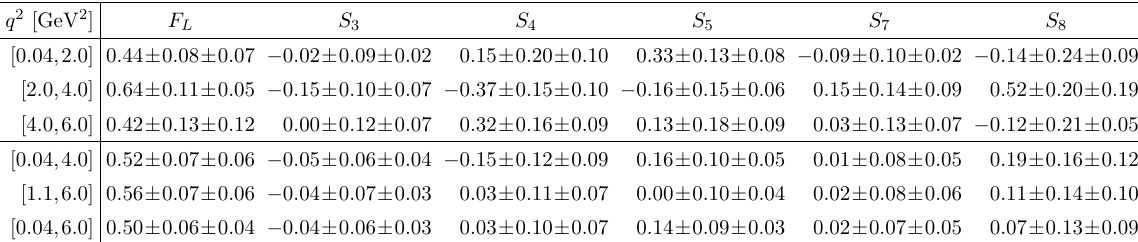
, and S , S , S , S and S parameters obtained for di(cid:11)erent bins in q 2 . L 3 4 5 7 8